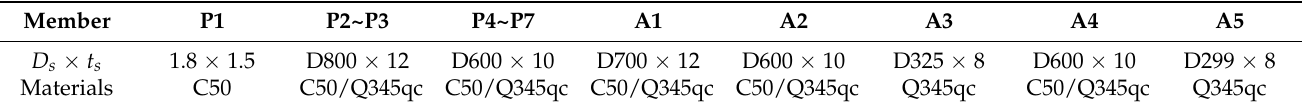
Table 4. Geometries and material composition of the